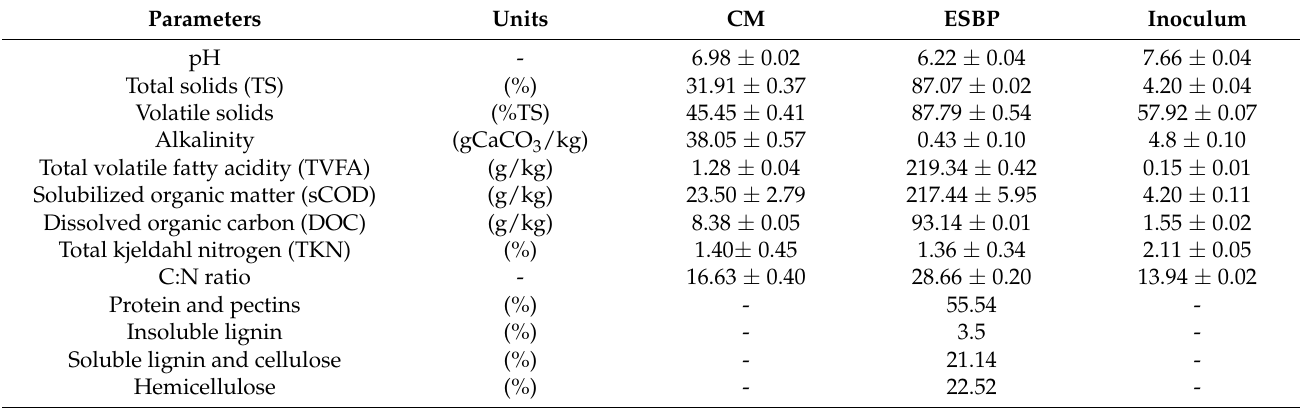
Table 1. Characterization of substrates and